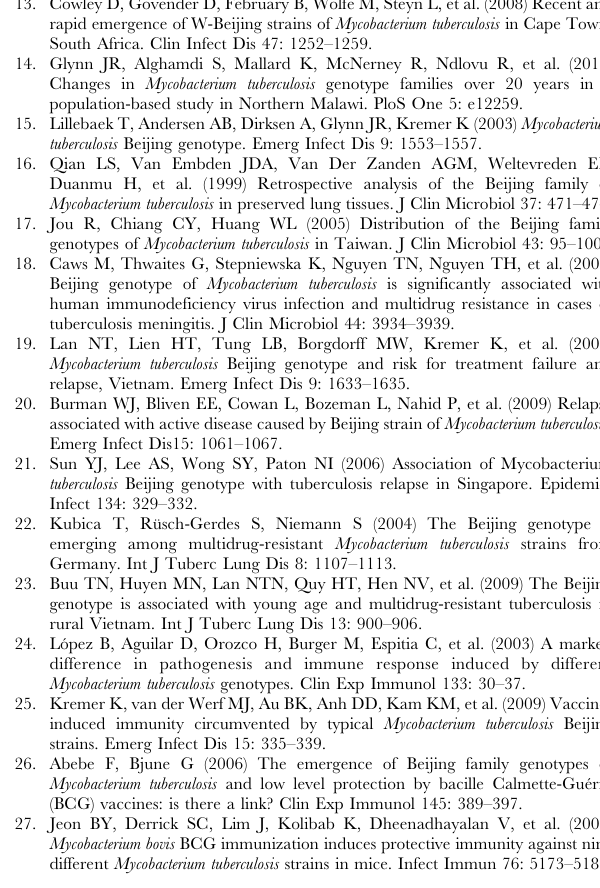
Table S1 Countries in the Western Pacific Region of the World Health Organization. Table S2 Demographic characteristics of included and excluded M. tuberculosis cases in Alberta, 1991–2007.